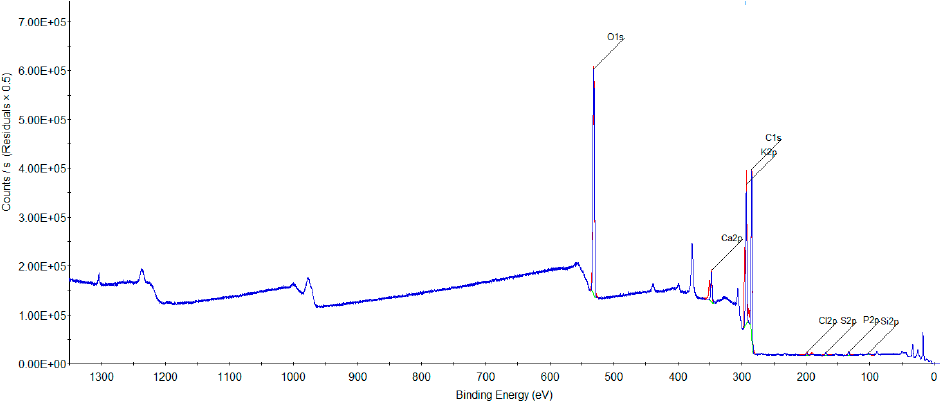
Figure 4. XPS spectrum of the pomelo peel ash. Table 2. XPS analysis.